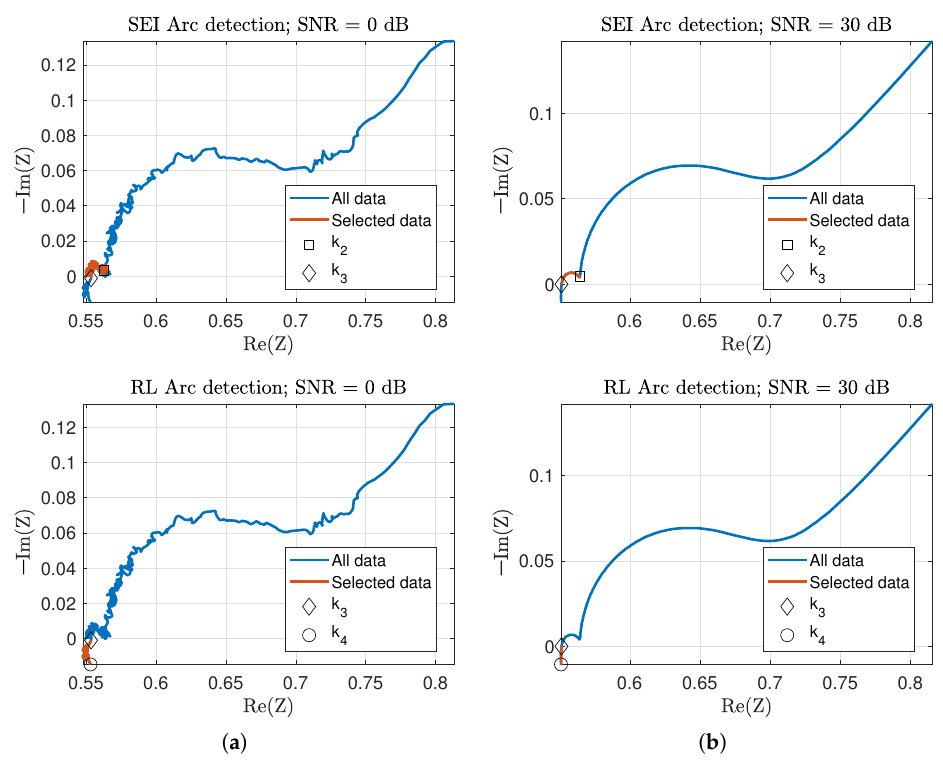
Figure 6. SEI Arc and RL Arc detection. The top plots show the detected SEI arc. The plots at the bottom depict the detected RL arc. ( a ) Low SNR. ( b ) High